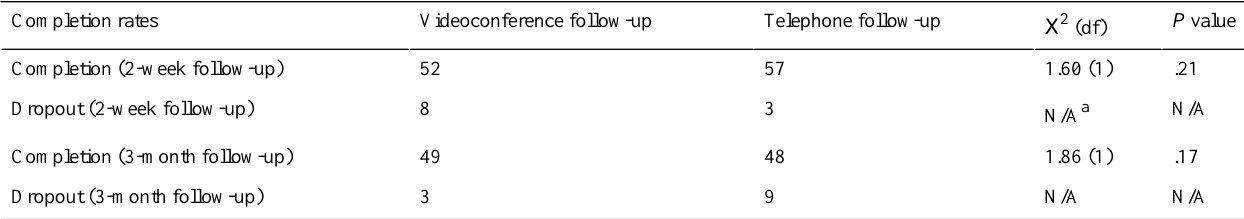
Table 6. Completion rates at 2-week and 3-month follow-up